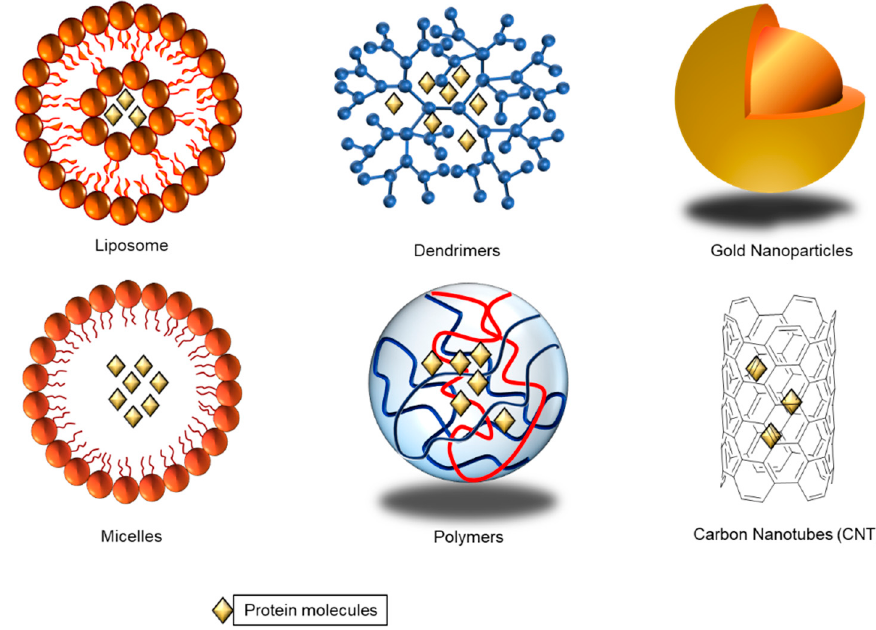
Figure 1. Types of nanoparticles used to carry drug or protein delivery into cells.